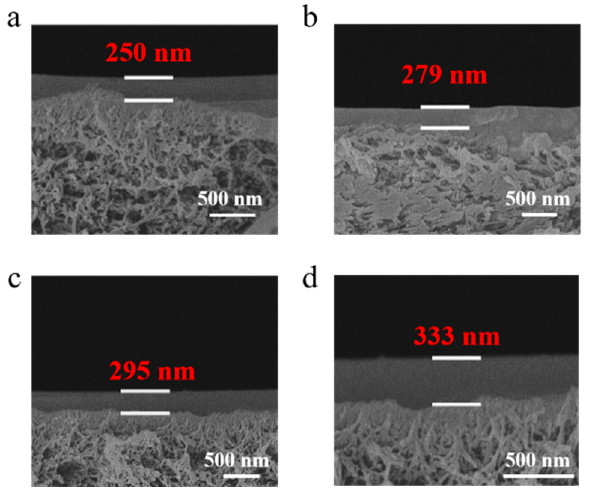
Figure 5. The cross-section topographies of the PPPS/PDMS/PSf composite membranes with differ- ent PPPS concentrations. The letters a~d respectively represent the concentration of PPPS used in membranes: 0.05 wt% ( a ), 0.10 wt% ( b ), 0.15 wt% ( c ), and 0.20 wt% ( d ). The wet coating thickness is 150 μ m.